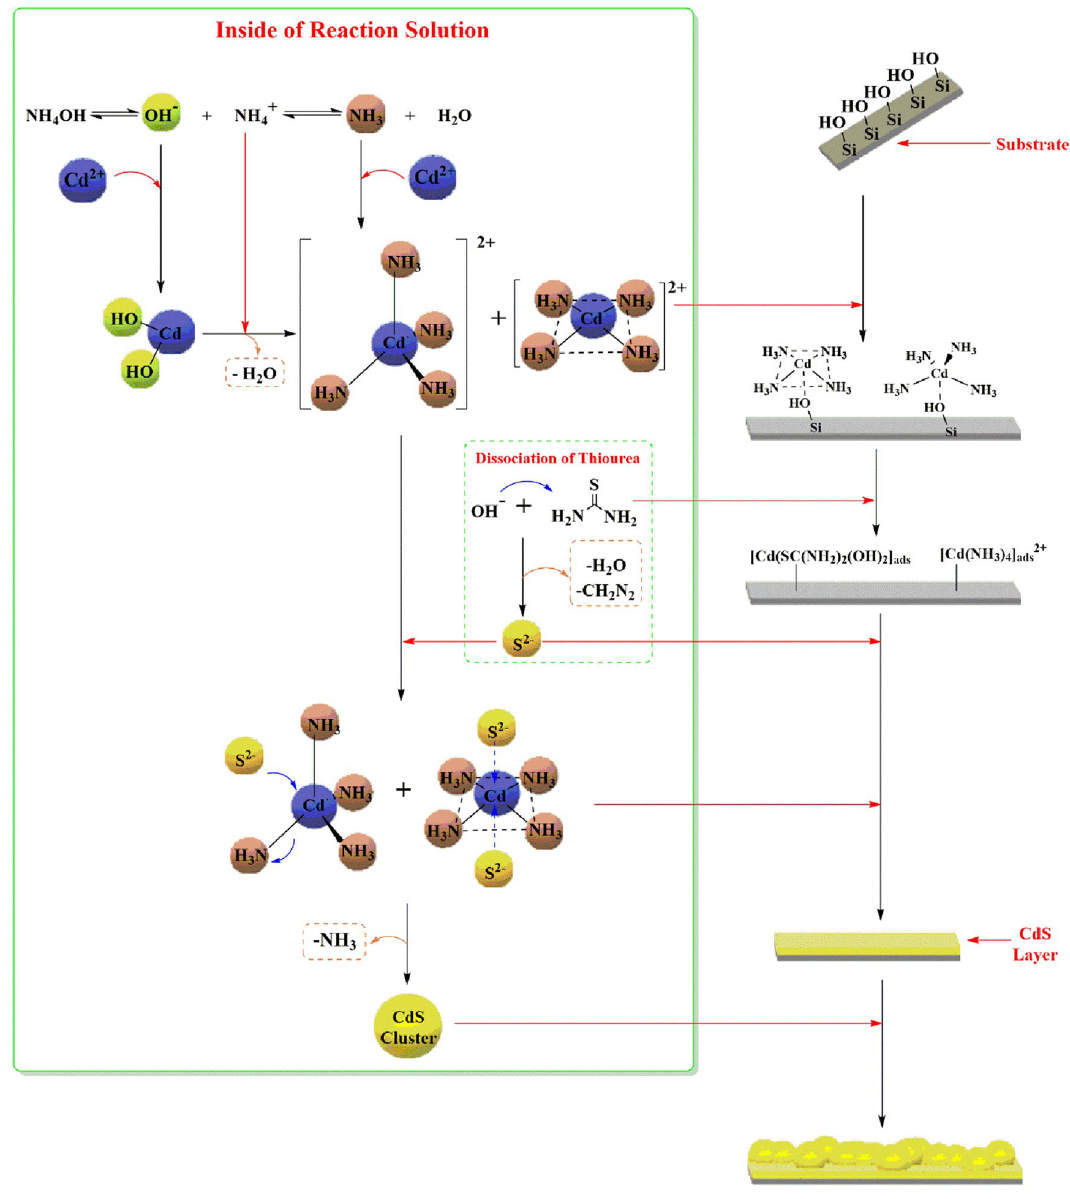
Figure 8. The growth mechanism of basic CdS in